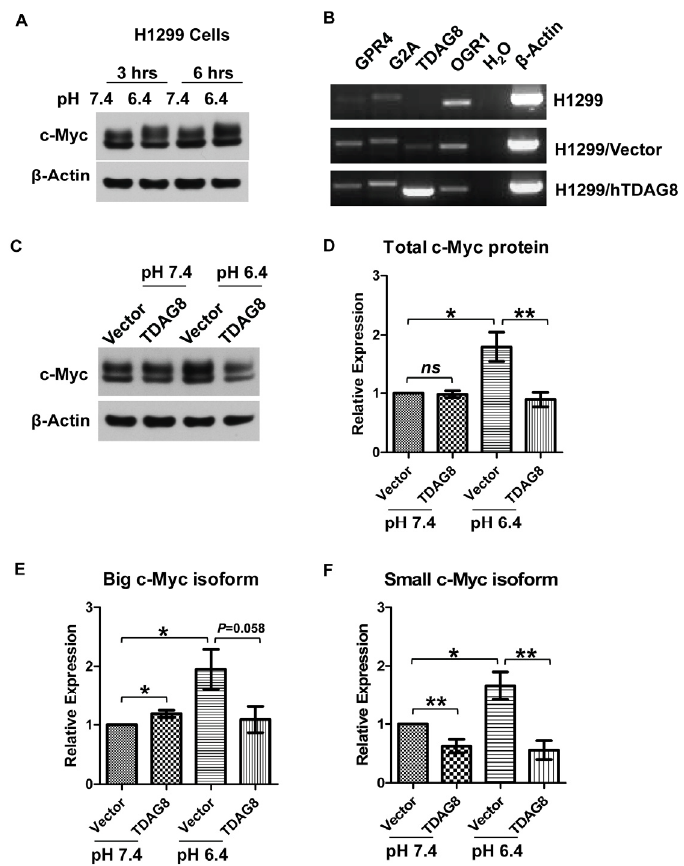
Figure 5. Ectopic overexpression of TDAG8 inhibits the upregulation of c-Myc protein by acidosis in H1299 cells. ( A ) c-Myc protein is moderately increased by acidosis in H1299 cells. Cells treated with HEM-buffered RPMI medium at pH 7.4 or pH 6.4 for three and 6 h were subject to Western blot assay using anti-c-Myc antibody. β -Actin was used as a loading control; ( B ) Low expression of proton-sensing GPCRs in H1299 cells. Total RNAs were isolated from H1299 parental, H1299/vector and H1299/hTDAG8 cells and subject to RT-PCR using gene-specific primers of GPR4, G2A, TDAG8 and OGR1. β -Actin was used as a positive control; ( C ) c-Myc protein is reduced by ectopic overexpression of TDAG8. Cells were treated with HEM-buffered RPMI medium at pH 7.4 or pH 6.4 for 3 h and, then, subject to Western blot assay using anti-c-Myc antibody. β -Actin was used as a loading control; ( D – F ) Quantification of Western blot results from ( C ). The expression of the total ( D ), big isoform ( E ) and small isoform ( F ) of c-Myc were quantified based on six Western blot repeats. The expression of c-Myc under the 3-h pH 7.4 treatment was set as one. Error bars indicate ±SEM. * p < 0.05; ** p < 0.01; ns, not significant ( p >